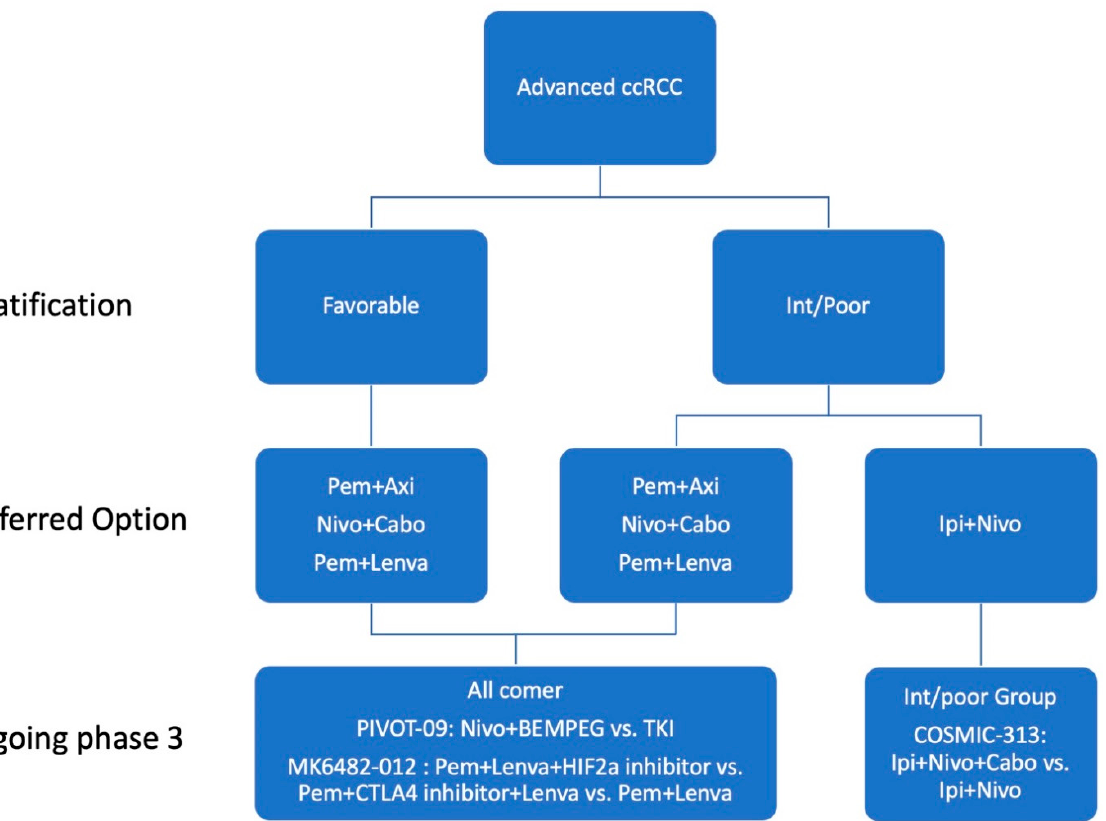
Figure 1. Current preferred treatment options and ongoing large-scale phase 3 trials in the first line setting of ccRCC. Axi, axitinib; BEMPEG, bempegaldesleukin; Cabo, cabozantinib; ccRCC, clear cell renal cell carcinoma; CTLA4, cytotoxic T-lymphocyte antigen 4; HIF2a, hypoxia inducible factor-2 alpha; Int, intermediate; Ipi, ipilimumab; Lenva, lenvatinib; Nivo, nivolumab; Pem, pembrolizumab; TKI, tyrosine kinase inhibitor.